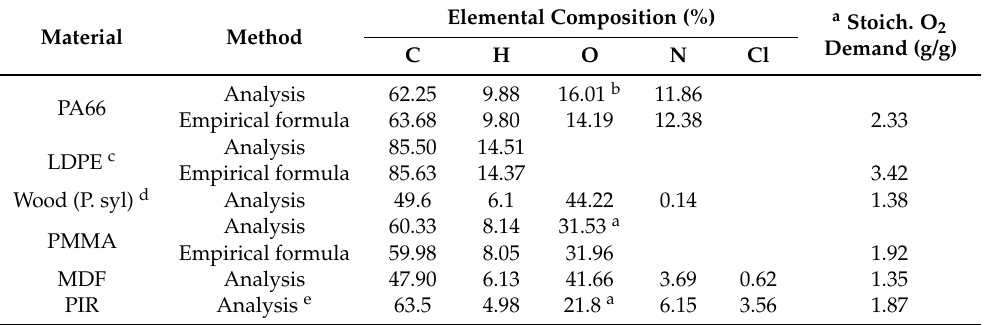
Table 2. Composition of test materials by elemental analysis and calculation from the empirical formula of the pure polymer. LDPE, low density polyethylene. Elemental Composition (%) a Stoich. O Material Method